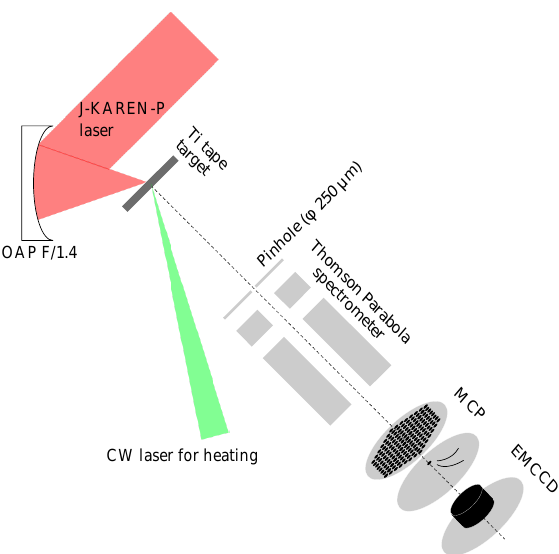
Figure 4. Schematic of the laser-driven ion acceleration experiment with the Ti tape target and Thomson parabola detector.